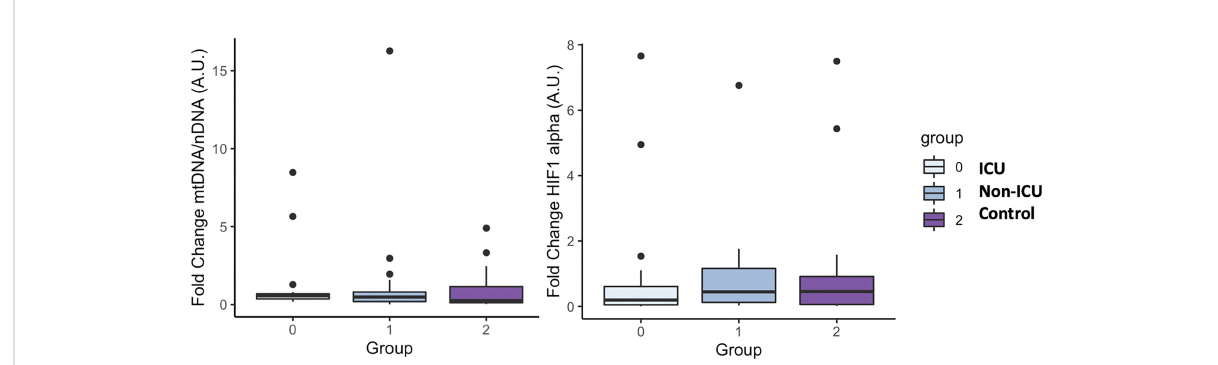
FIGURE 7 mtDNA and HIF1 alpha mRNA levels in COVID-19 patients and the uninfected control group. The box plots represent the maximum and minimum levels (whiskers), the upper and lower quartiles, and the median. The length of each box represents the interquartile range. Dots represent outliers. Statistical signi fi cance between groups was determined using the ANOVA test. No difference were found in mtDNA and HIF1 alpha mRNA levels among groups.